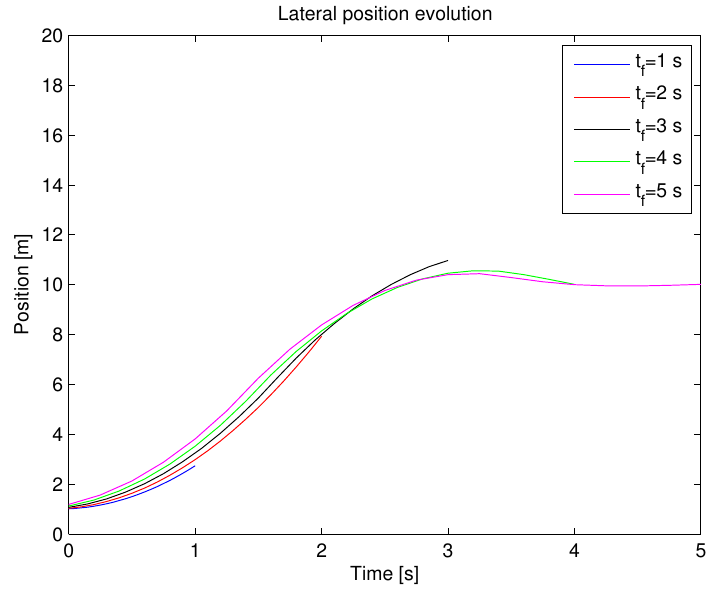
for different t D 4 f